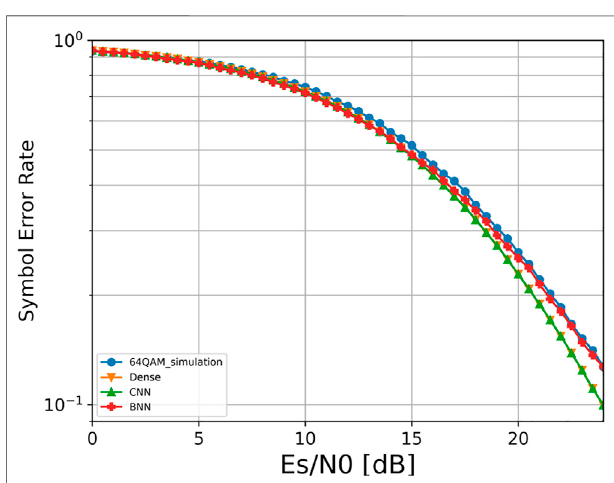
FIGURE 8 | The performance of four different network structures under Rayleigh